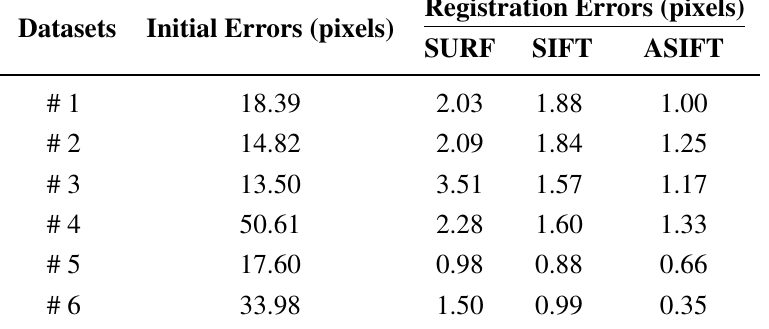
Table 1. Quantitative Evaluation: Mean displacements (in pixels) before and after the developed automated registration process. These registration errors have been computed from the manually denoted points which an expert had designated after a careful photo- interpretation in every spectral band. Registration Errors Datasets Initial Errors (pixels)